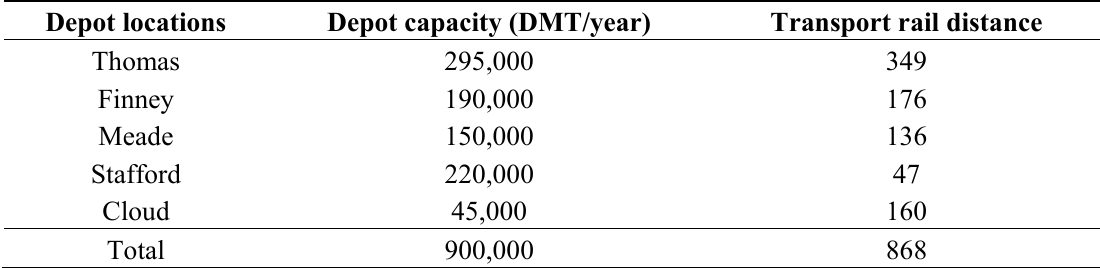
Table 2. Preprocessing depot capacities and true rail distance from depots to the single biorefinery in Scenario